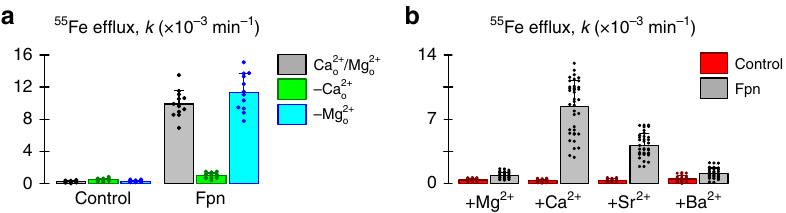
Fig. 2 Alkaline-earth metal selectivity. a 55 Fe ef fl ux from control oocytes and oocytes expressing Fpn, in the presence of extracellular calcium (2 mM) and magnesium (1 mM), the absence of extracellular calcium ( – Ca 2 + o i.e. 0 mM Ca 2 + plus 1 mM EGTA), or the absence of extracellular magnesium ( – Mg 2 + o ) i.e. 0 mM Mg 2 + plus 1 mM EDTA) ( n = 12 in each group). Two-way ANOVA: interaction ( P < 0.001); within Fpn, all groups differ from one another ( P ≤